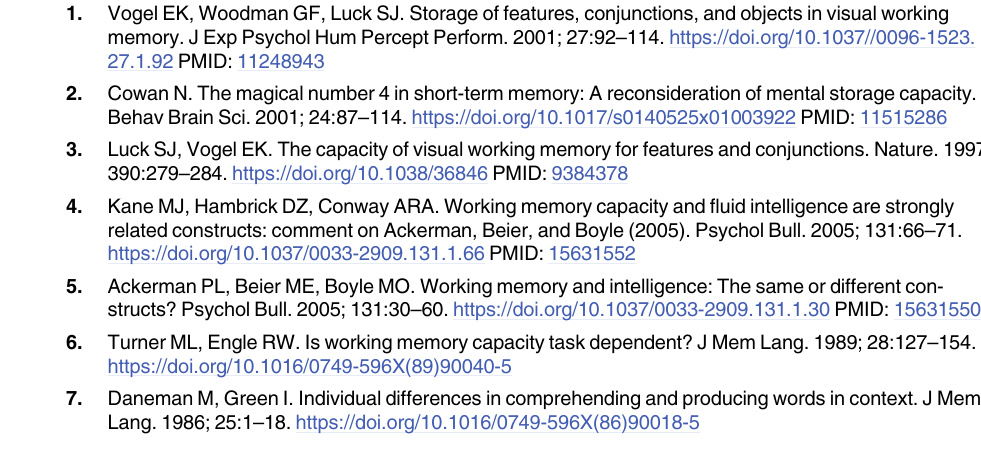
S1 Fig. Bivariate relations between individuals’ WM capacities and amplitudes of isolated ERP indices of inhibition in Experiment 1. The underlying data supporting this figure can be found at https://osf.io/4wdzq. ( A ) Distractor-suppression activity over the posterior scalp (P on No-Go trials of Experiment 1 did not predict WM capacity. ( B ) Response-suppression activity over the central scalp (no-go P3) on No-Go trials of Experiment 1 did not predict WM